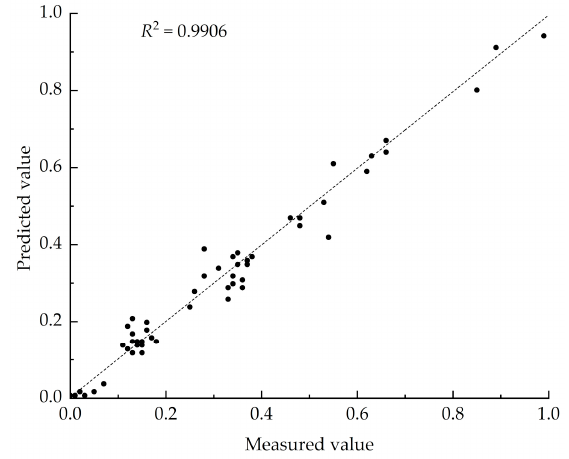
Figure 6. Linear fitting of the measured and predicted values of Ground-DSR.